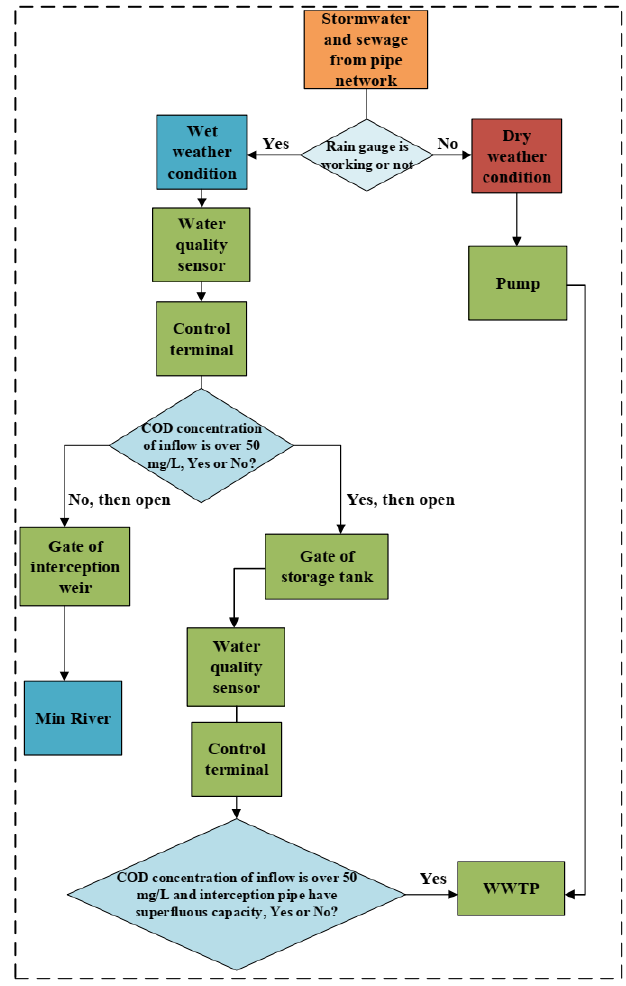
Figure 11. Working flow chart of double-gate scheme based on water